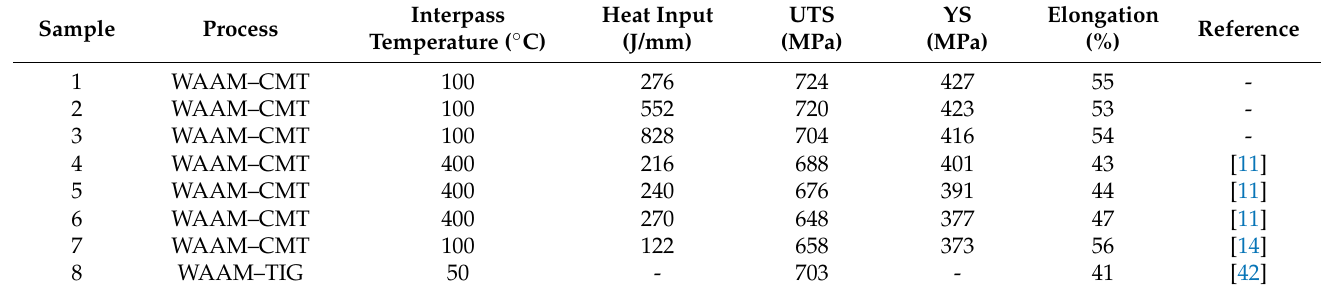
Table 5. Comparison of average tensile properties of Inconel 625 fabricated by using different processes.